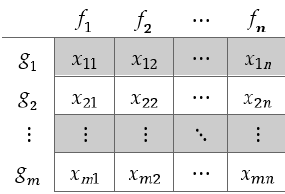
), subgroups ( g ), and decision variables ( x ji ). i j